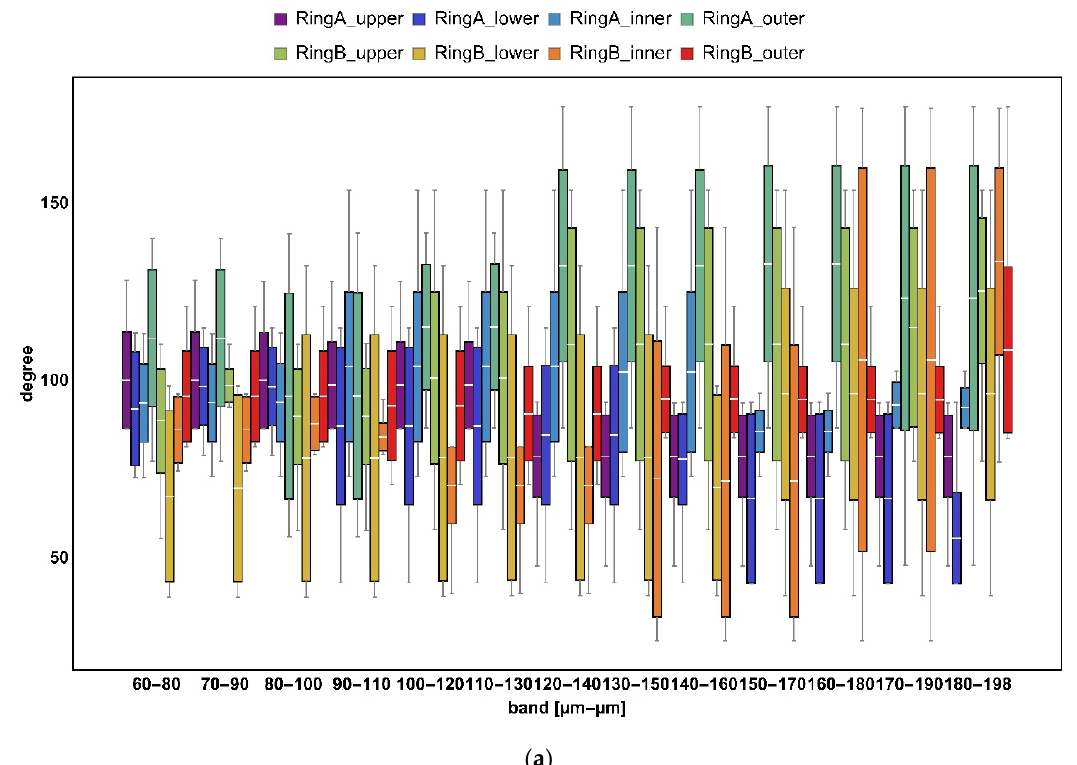
Figure 6. Evolution of arithmetic mean height (Sa) with scale for three different bandwidths: ( a ) 20, ( b ) 50, and ( c ) 100 µm.